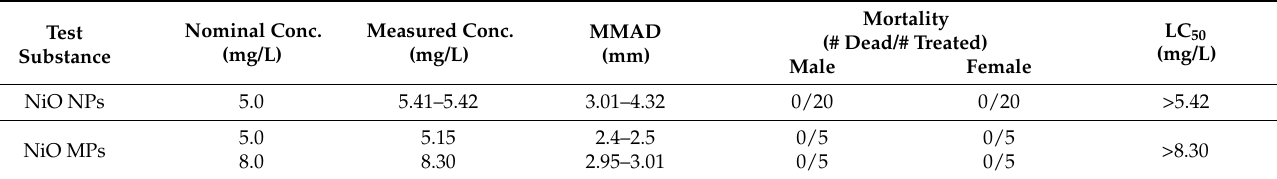
Table 4. Acute inhalation exposure